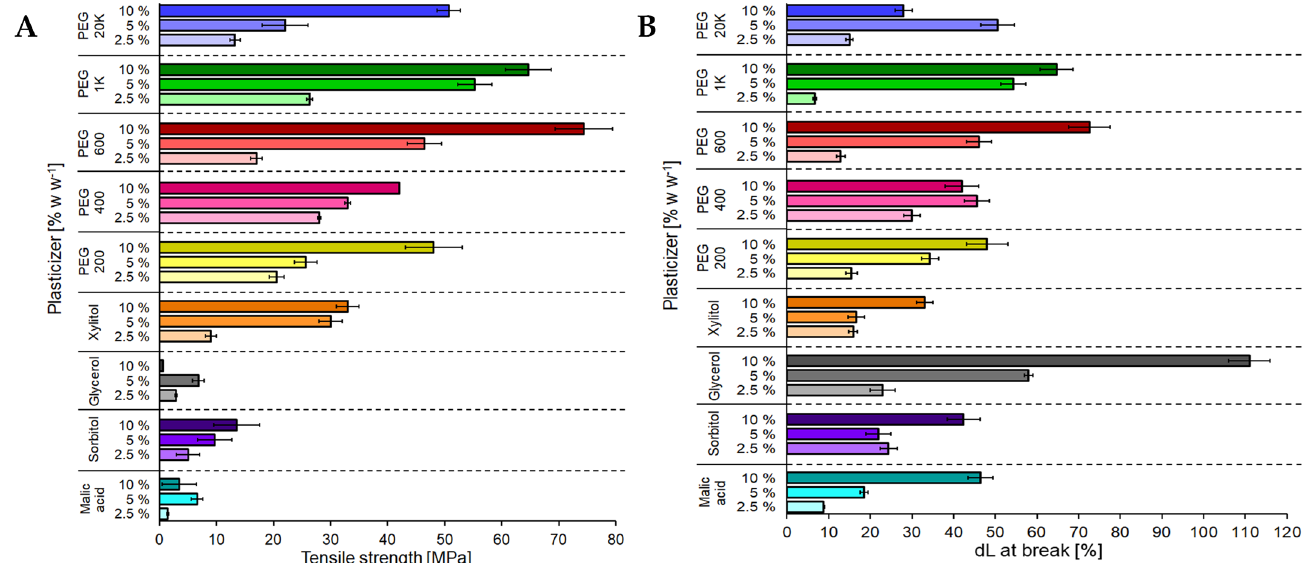
Figure 8. Effects of different plasticizers, in various amounts, on the tensile strength ( A ) and elongation at break ( B ) of laccase-polymerized lignosulphonates [154].